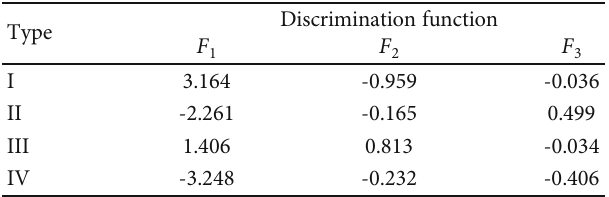
Table 5: Central values of discrimination functions in di ff erent groups.